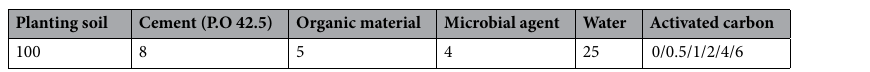
Table 3. Weight ratio of each component in vegetation concrete.